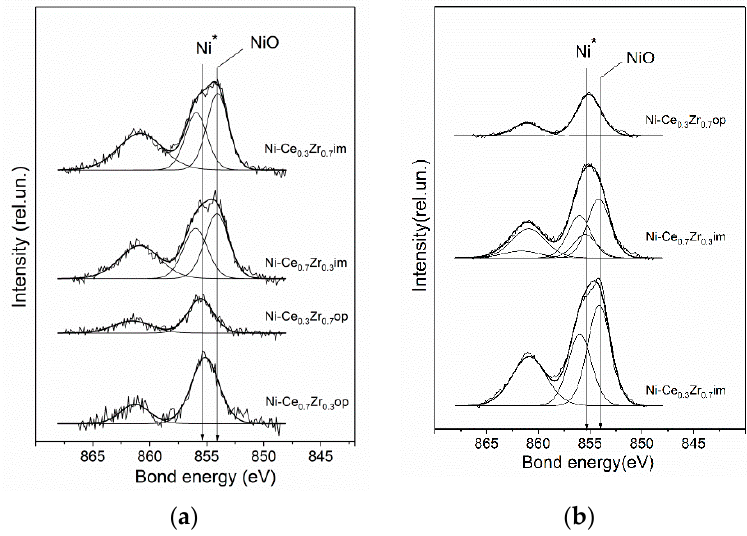
Figure 10. Ni2p 3 / 2 spectra for the fresh ( a ) and reduced ( b ) catalysts prepared by impregnation and Figure 10. Ni2p 3/2 spectra for the fresh (a) and reduced (b) catalysts prepared by impregnation and one-pot method. one-pot method. Table 3. Surface characteristics of NiCeZrO catalysts.